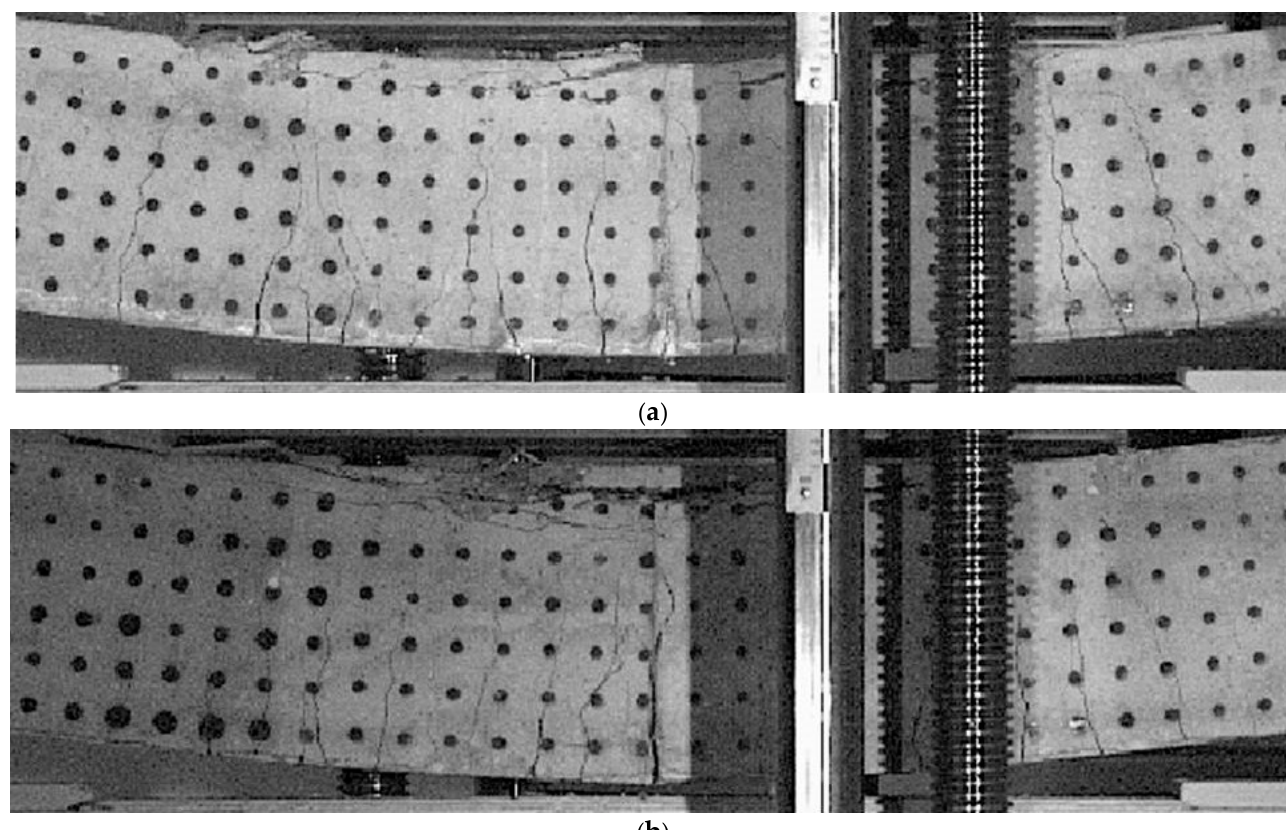
Figure 10. Zoomed view of the final cracking pattern for beams of Series 2: ( a ) beam C-s2 for c6(Q = 52.398 kN, v A = 116.0 mm), ( b ) beam T-s2 for t6(Q = 59.392 kN, v A = 119.6 mm).